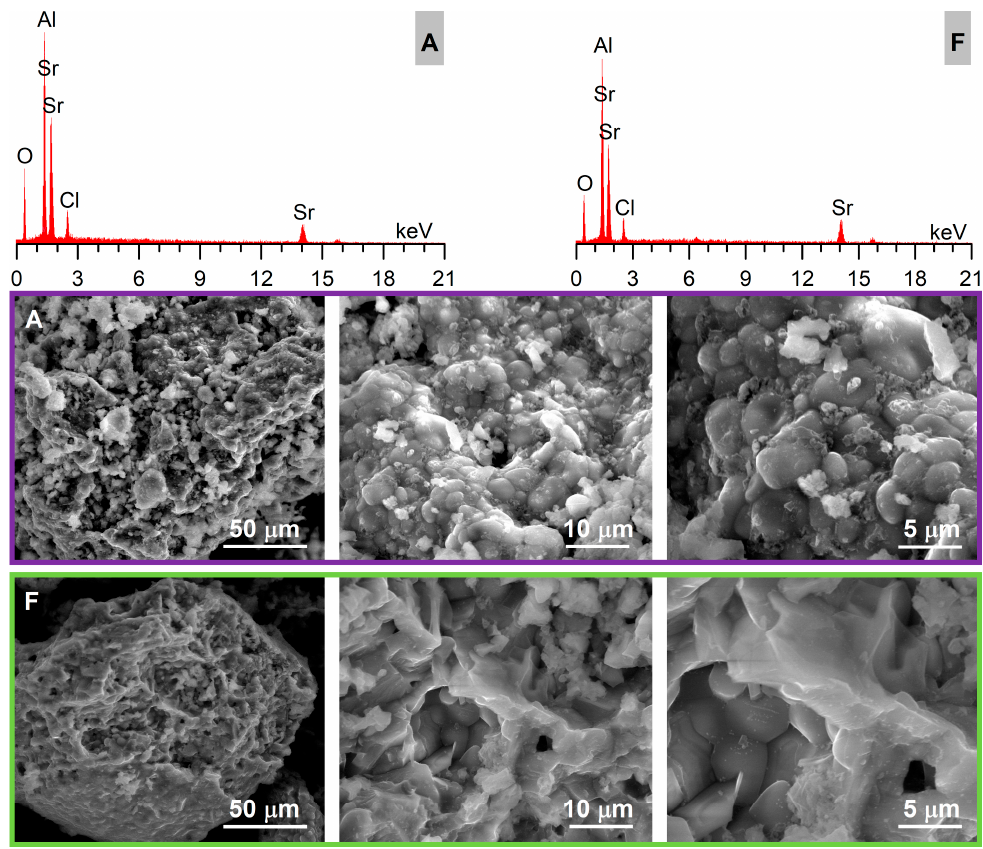
The EDX and SEM micrographs (Figure 11) of reference sample A (stoichiometric) and